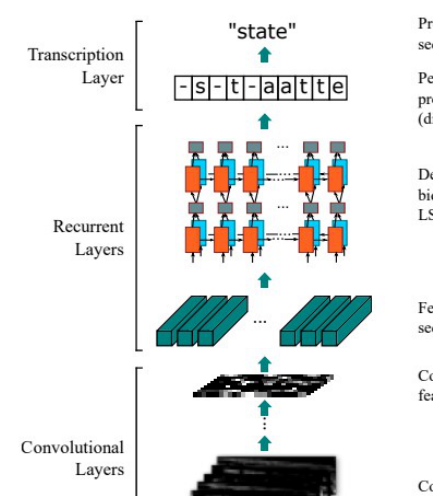
Figure 5. The network architecture of convolutional recurrent neural network for recognizing scene text. The architecture consists of three parts: 1) convolutional layers, which extract a feature sequence from the input image; 2) recurrent layers, which predict a label distribution for each frame; 3) transcription layer, which translates the per-frame predictions into the final label sequence(Shi et al.,